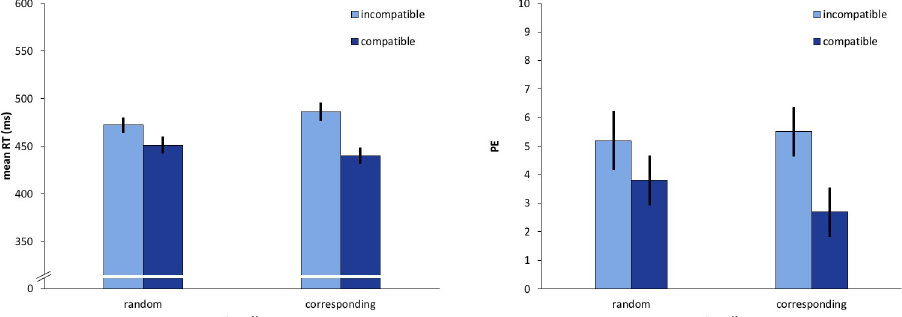
Fig 2. Results of Experiment 1. Mean Reaction times (RT) in ms (left) and percentage errors (PE, right) as a function of avatar compatibility and action effect. Error bars represent 95% within-subject CIs